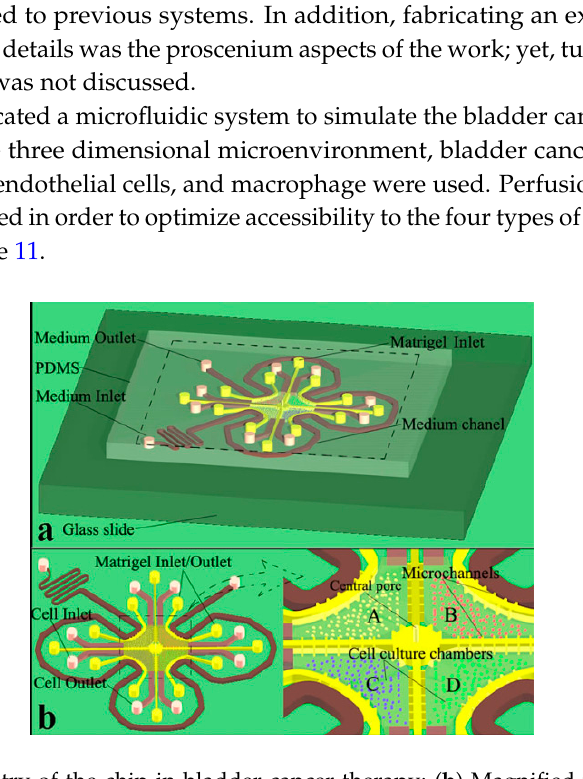
Figure 11. ( a ) Geometry of the chip in bladder cancer therapy; ( b ) Magnified view of cell culture chambers where bladder cancer cells are cultured in indirectly connected central chambers (A–D) [101].